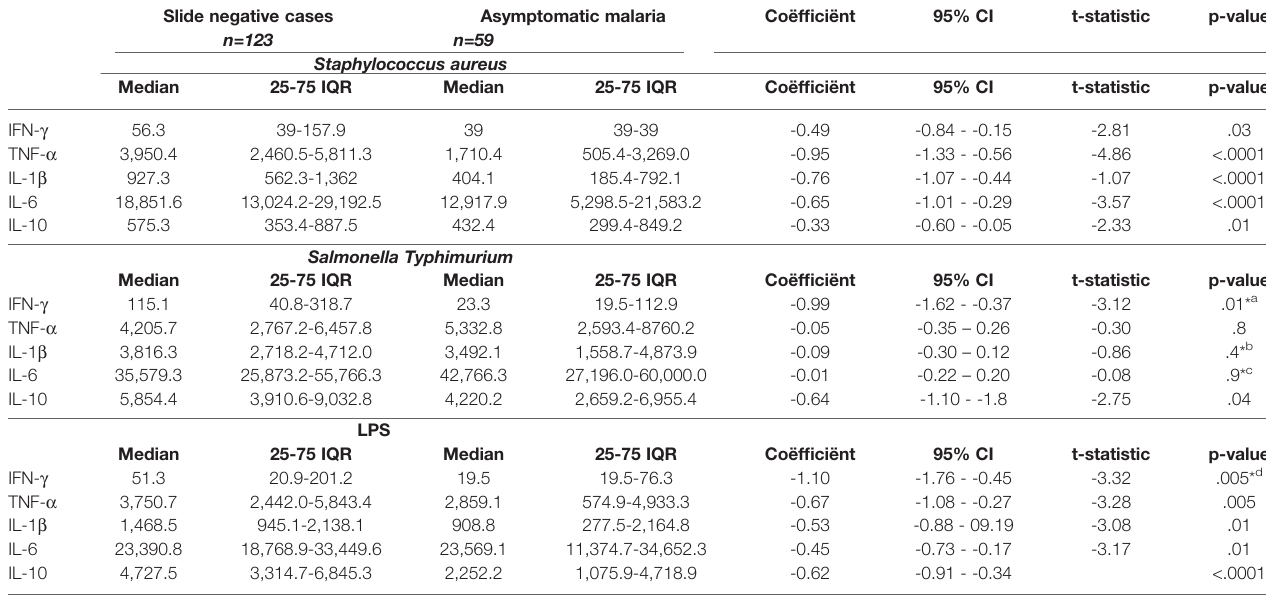
TABLE 4 | Multivariable regression analyses of whole blood stimulated samples among slide negative participants and participants with asymptomatic malaria. Slide negative